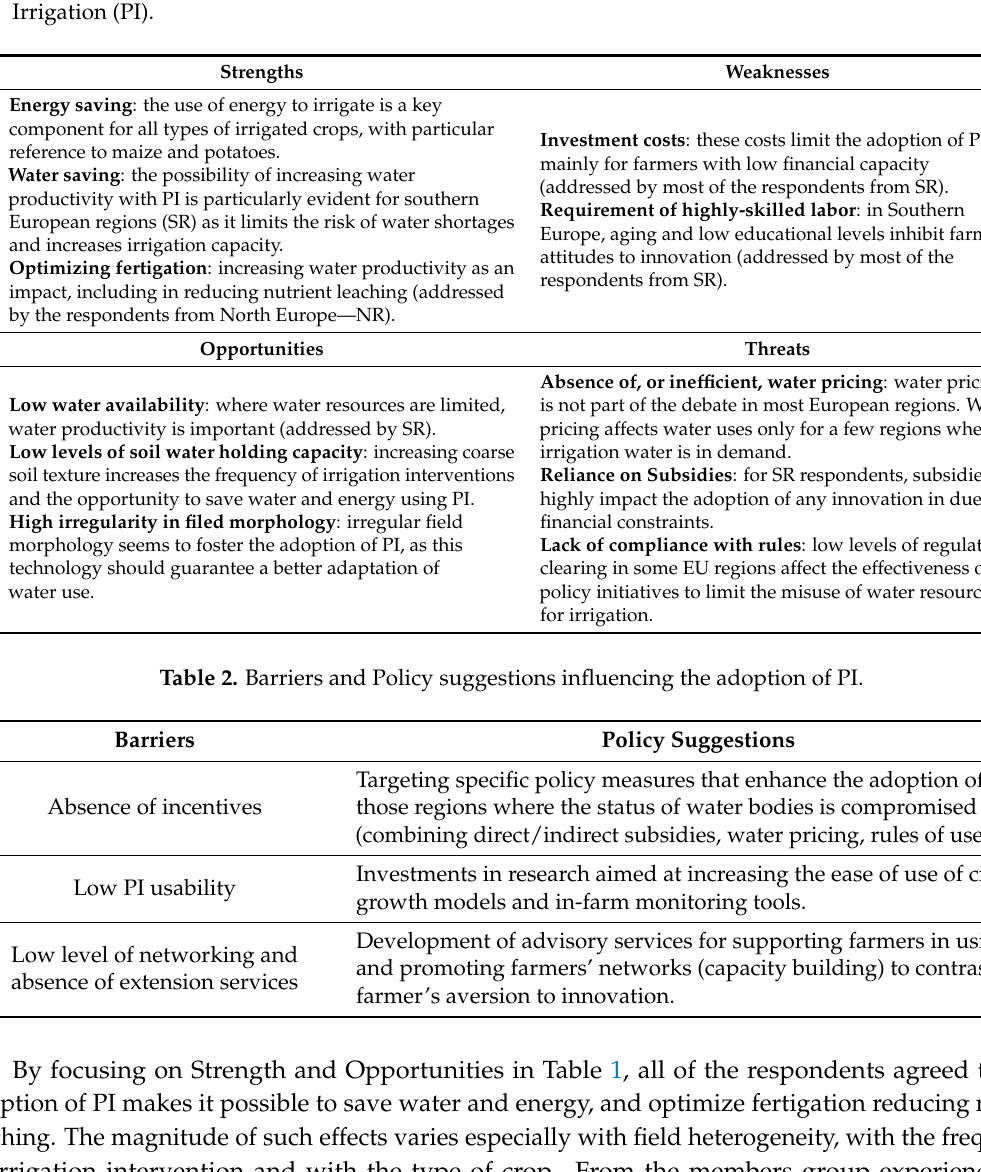
Table 1. Strengths, Weaknesses, Opportunities and Threats (SWOT) analysis of the adoption of Precision Irrigation (PI).